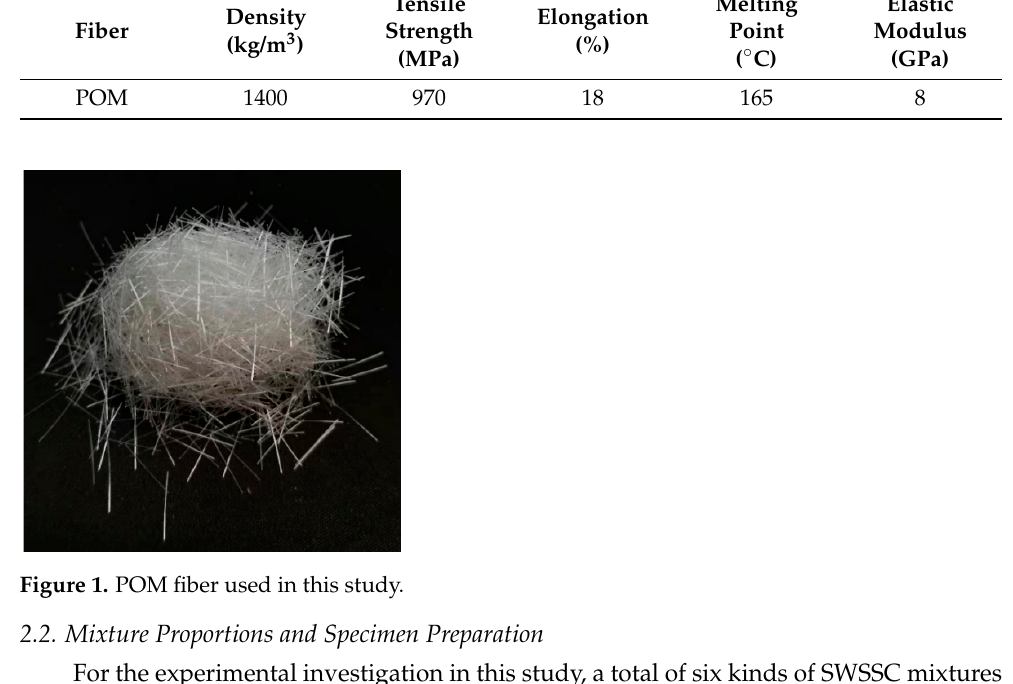
Table 4. Proportions of all SWSSC